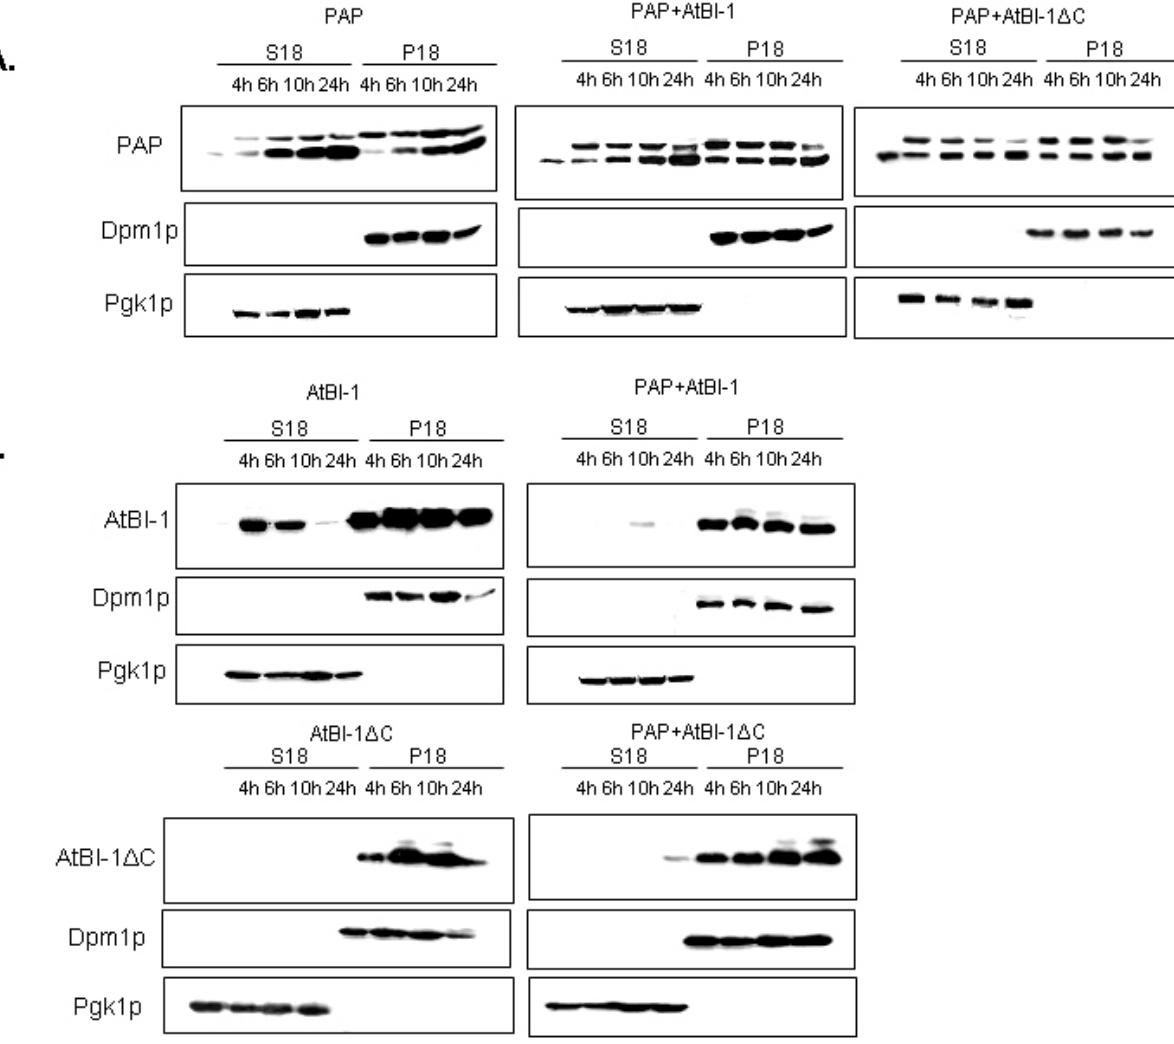
FIGURE 7 : Immunoblot analysis. (A) PAP expression in yeast cells expressing AtBI-1 or AtBI-1 D C. (B) AtBI-1 or AtBI-1 D C expression in yeast cells expressing PAP. Yeast transformants were grown in SD-U-L glucose media. The expression of PAP and AtBI-1 was induced for indicated hours, lysed and fractionated into membrane (P18) and cytosolic (S18) components. The amount of 10 mg protein was separated on 15 % SDS-PAGE. Proteins were transferred into nitrocellulose membrane and probed with polyclonal PAP antiserum and monoclonal V5 antibody. The membrane marker Dpm1p and the cytosolic marker Pgk1p were used as controls to show equal amount of loading and lack of cross-